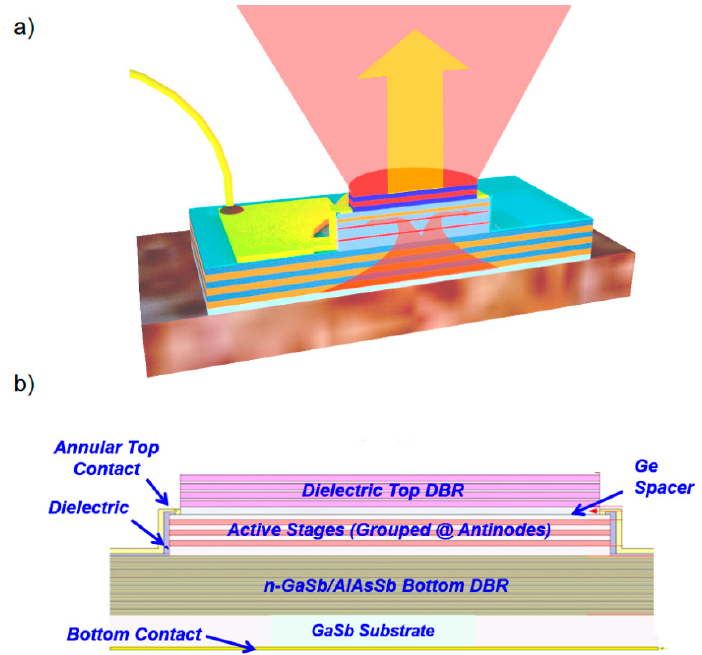
Figure 16. ( a ) Schematic of the epitaxial-side-up mounted ICVCSEL architecture employed by NRL; ( b ) schematic of the layered design, showing the GaSb substrate, grown GaSb/AlAsSb bottom mirror, active stages (grouped at antinodes of the optical field), deposited Ge spacer layer, and the deposited dielectric top mirror.